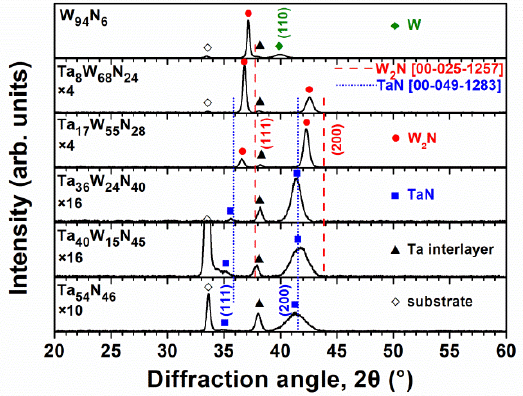
Figure 7. Bragg–Brentano XRD patterns of the TaWN films.